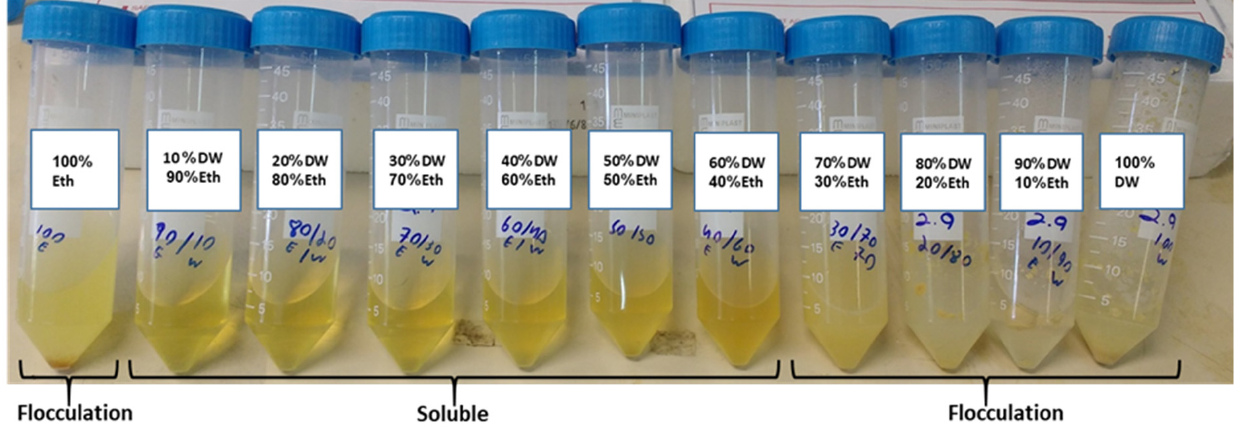
Figure 1. Solubility of CZ protein in ethanol /water mixture.